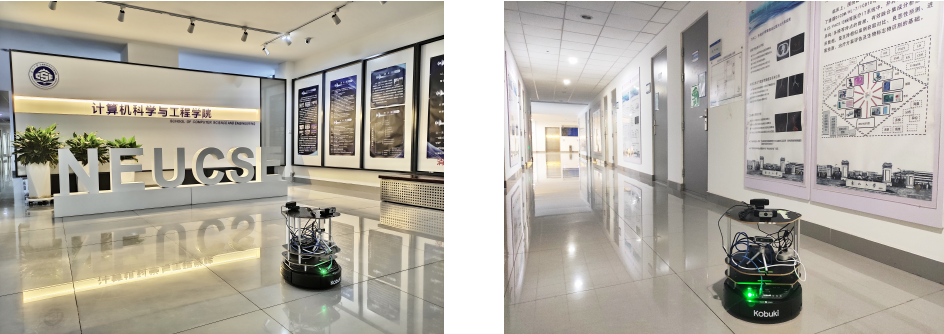
Figure 2. Robot navigating using PicPose